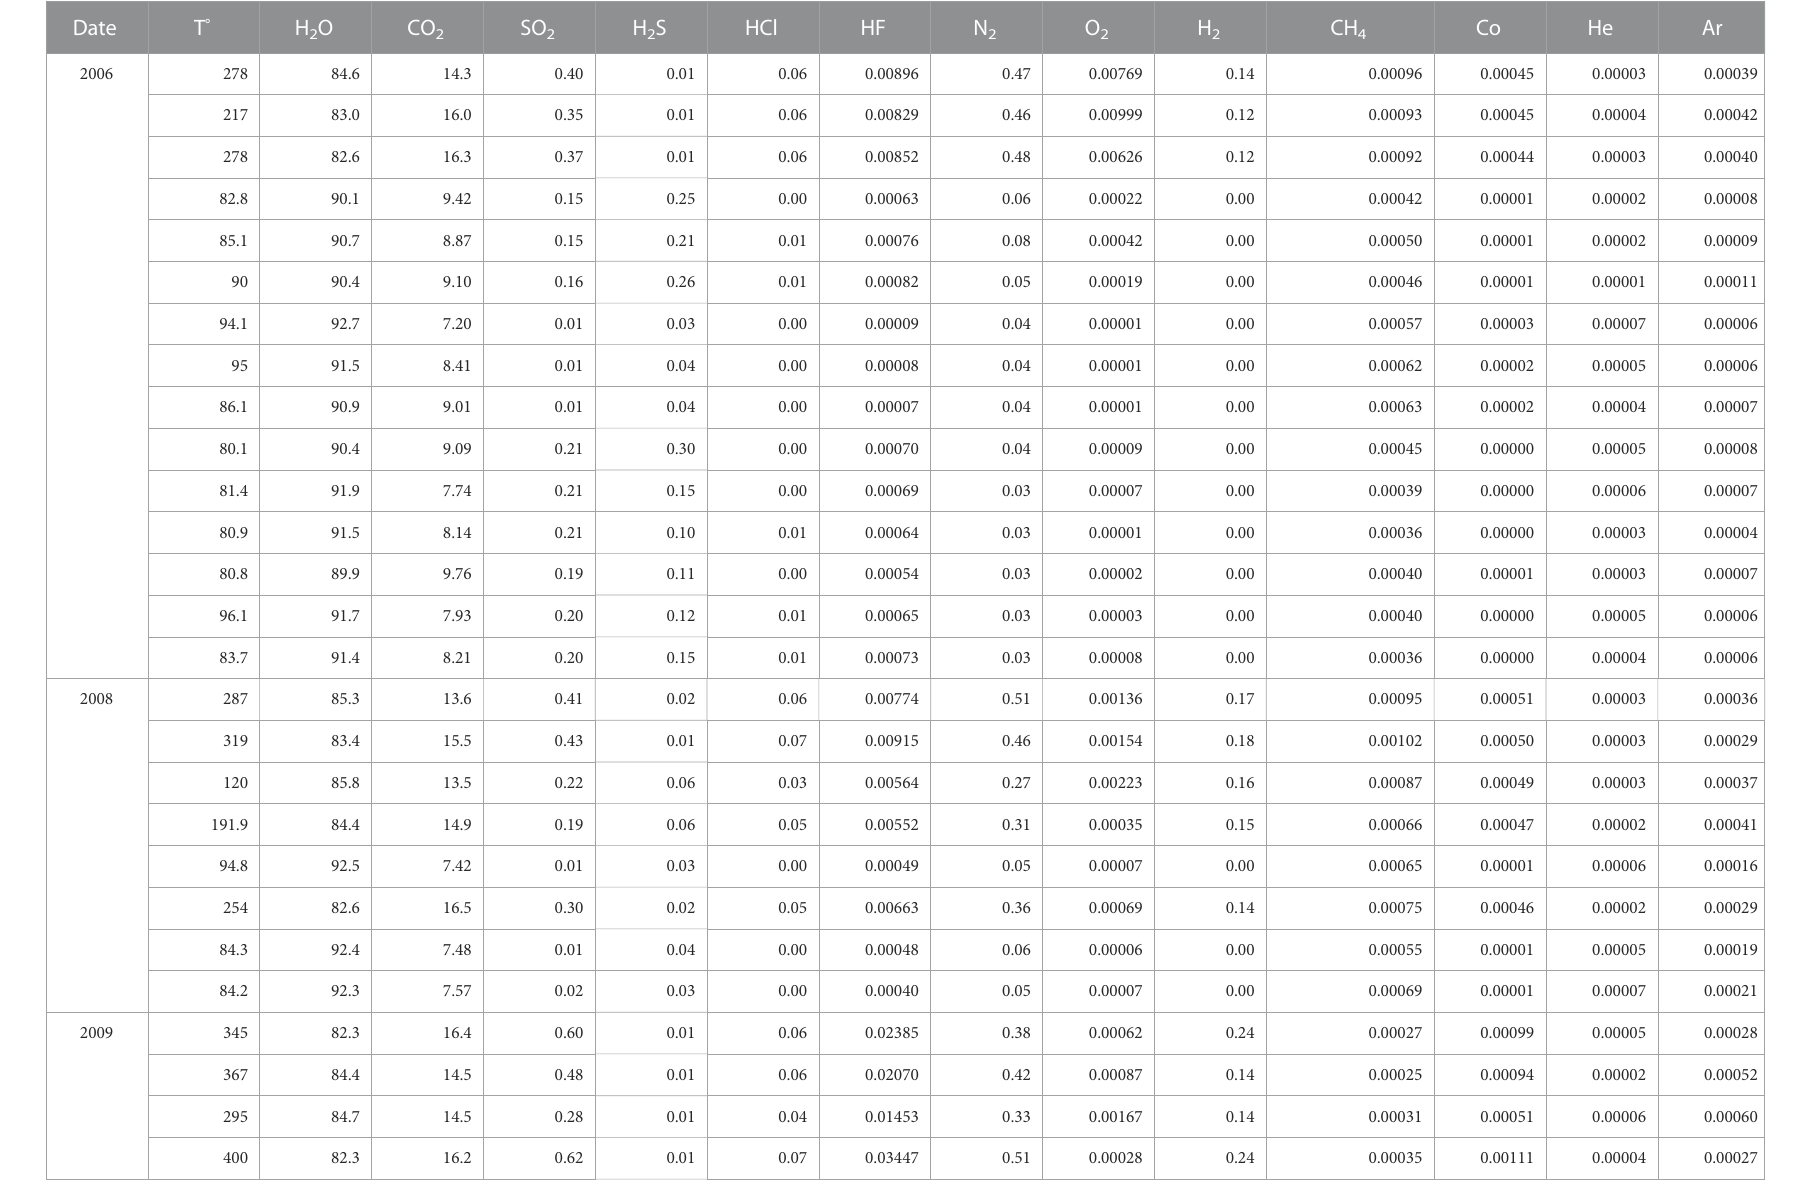
TABLE 4 Temperature (in ° C) and chemical composition (in mol%) of fumarolic gases from Lastarria